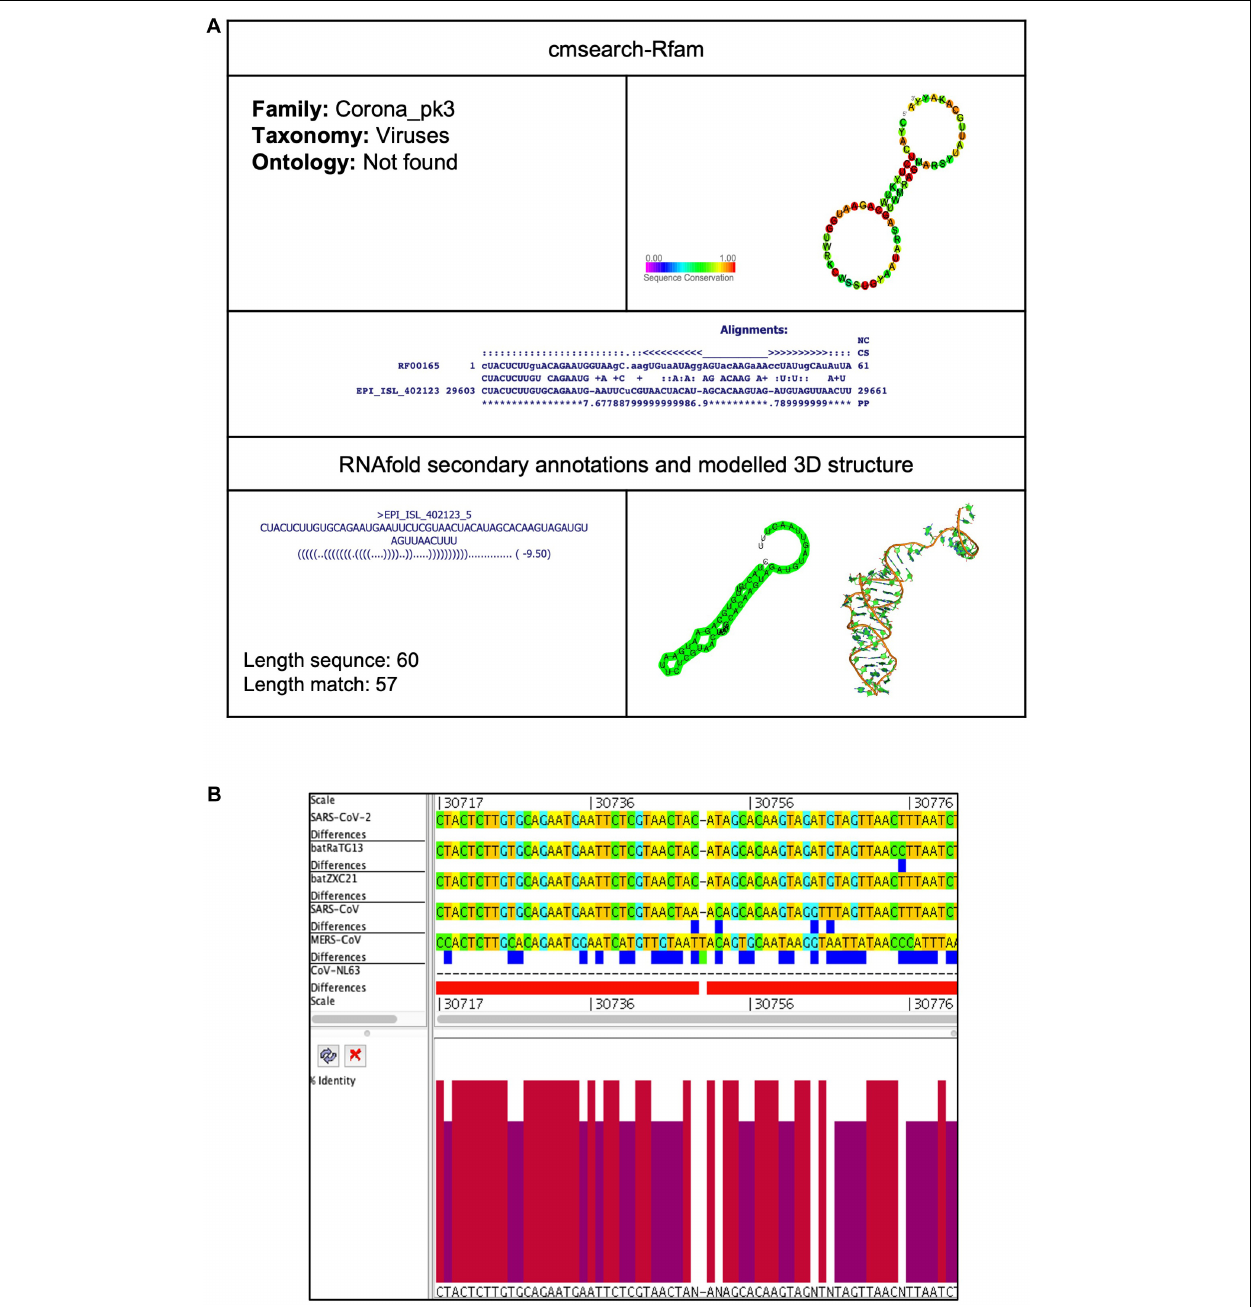
FIGURE 8 | Corona_pk3 cis -acting RNA element in the SARS-CoV-2 genome. (A) The sequence and RNA structure of Corona_pk3 is located in position 29,603–29,661 of the SARS-CoV-2 genome. In the 3-D structure, the phosphodiester backbone is shown in orange, and the nucleotides are shown in the sticks and filled rings with elemental coloring as C green, O red, and N blue. (B) Conservation of Corona_pk3 RNA sequence from various CoVs. The Corona_pk3 is located as aligned position 30,717–30,776. The navy blue box indicates mismatched nucleotides between the two sequences, and the red box indicates gaps between two sequences. Percentae identity in the histogram in which red indicates a perfect match and magenta indicates the low similarity of